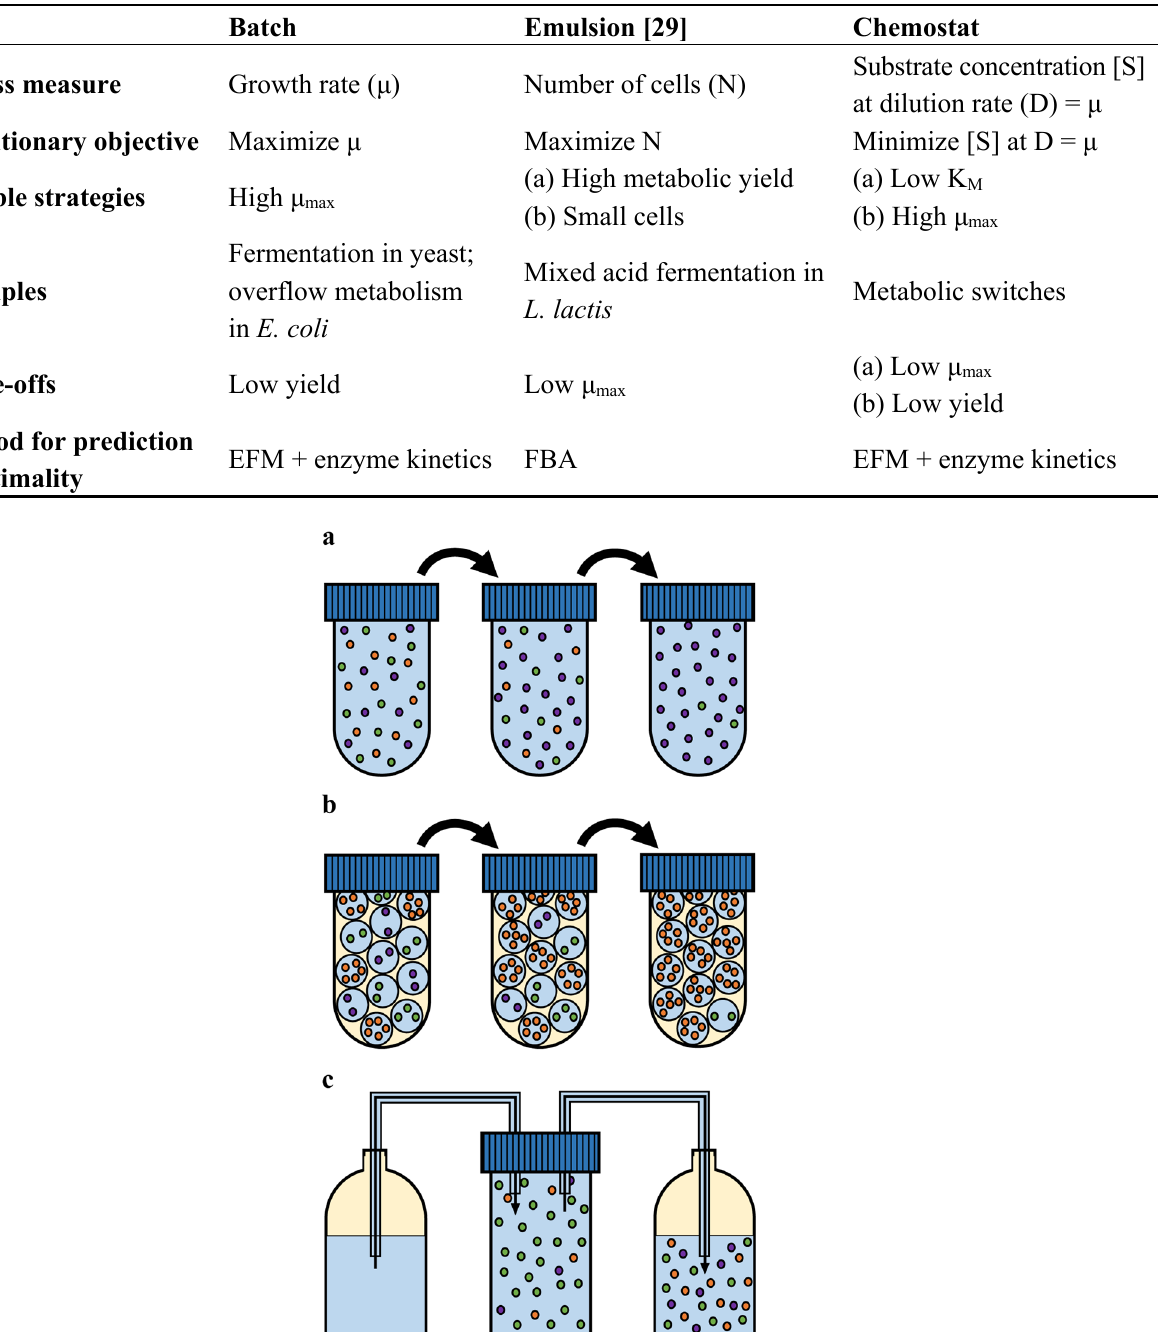
Table 1. Summary of main properties of experimental culturing methods.